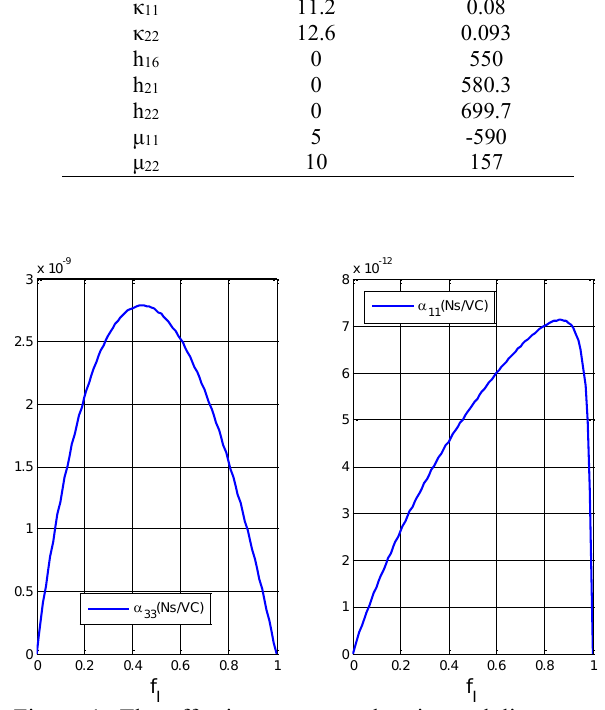
Figure 1: The effective magneto-electric moduli α 11 et α 33 presented for a fibrous magneto-electro-elastic composite constituted of piezo-electric inclusions embedded in a piezo- magnetic matrix versus the volume fraction of the piezo- electric